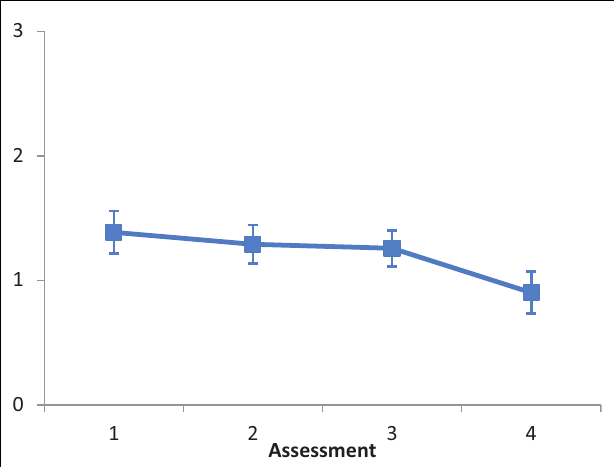
FIGURE 4 | LN patients’ performance on the Serving tea subtest as a function of assessment . Error bars represent 1 SEM.